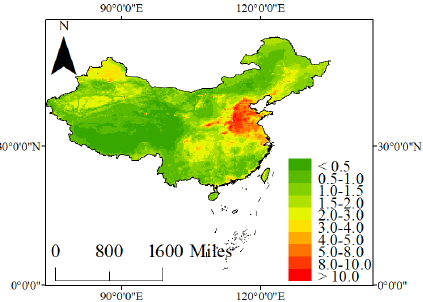
− concentration 3